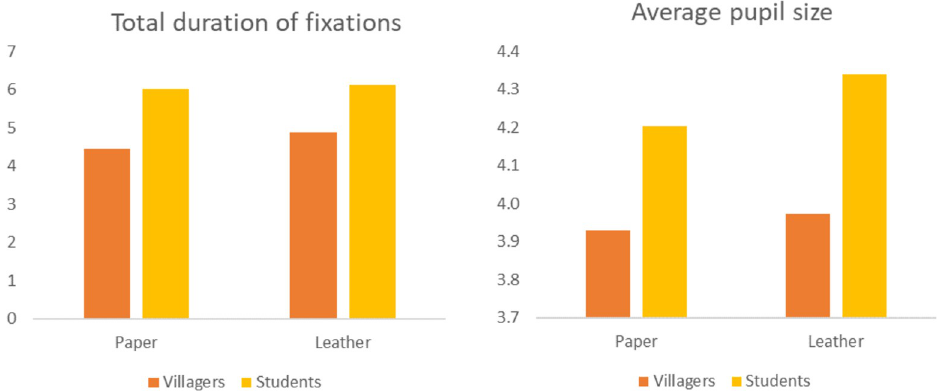
Fig 5. The average value of eye movement indicators of villagers and students on different leaf qualities.